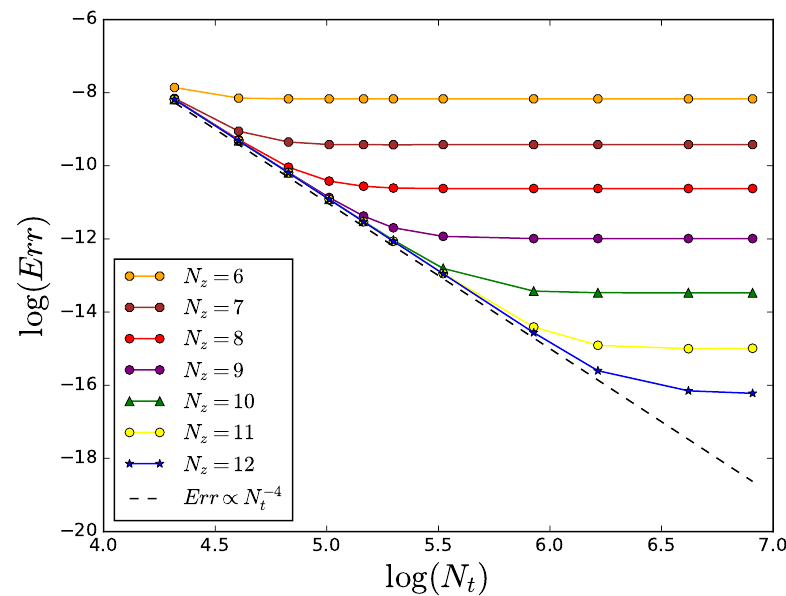
Figure 2 . Numerical error as a function of the number of timesteps N t . The di(cid:11)erent curves correspond to di(cid:11)erent numbers N z of spatial lattice points. Here we study a Gaussian pulse (cid:16) (cid:17) E x ( t ) = A cos( ! P t ) exp (cid:0) ( t (cid:0) t 0 ) 2 with the choice of parameters: A = 0 : 5, t 0 = 3, (cid:1) t P = 1, ((cid:1) t ) 2 ! P = (cid:25)= 2, (cid:26) = 0 : 5, k = 1 : 0, m I = 0 : 5, where m I is the initial mass of the black hole.